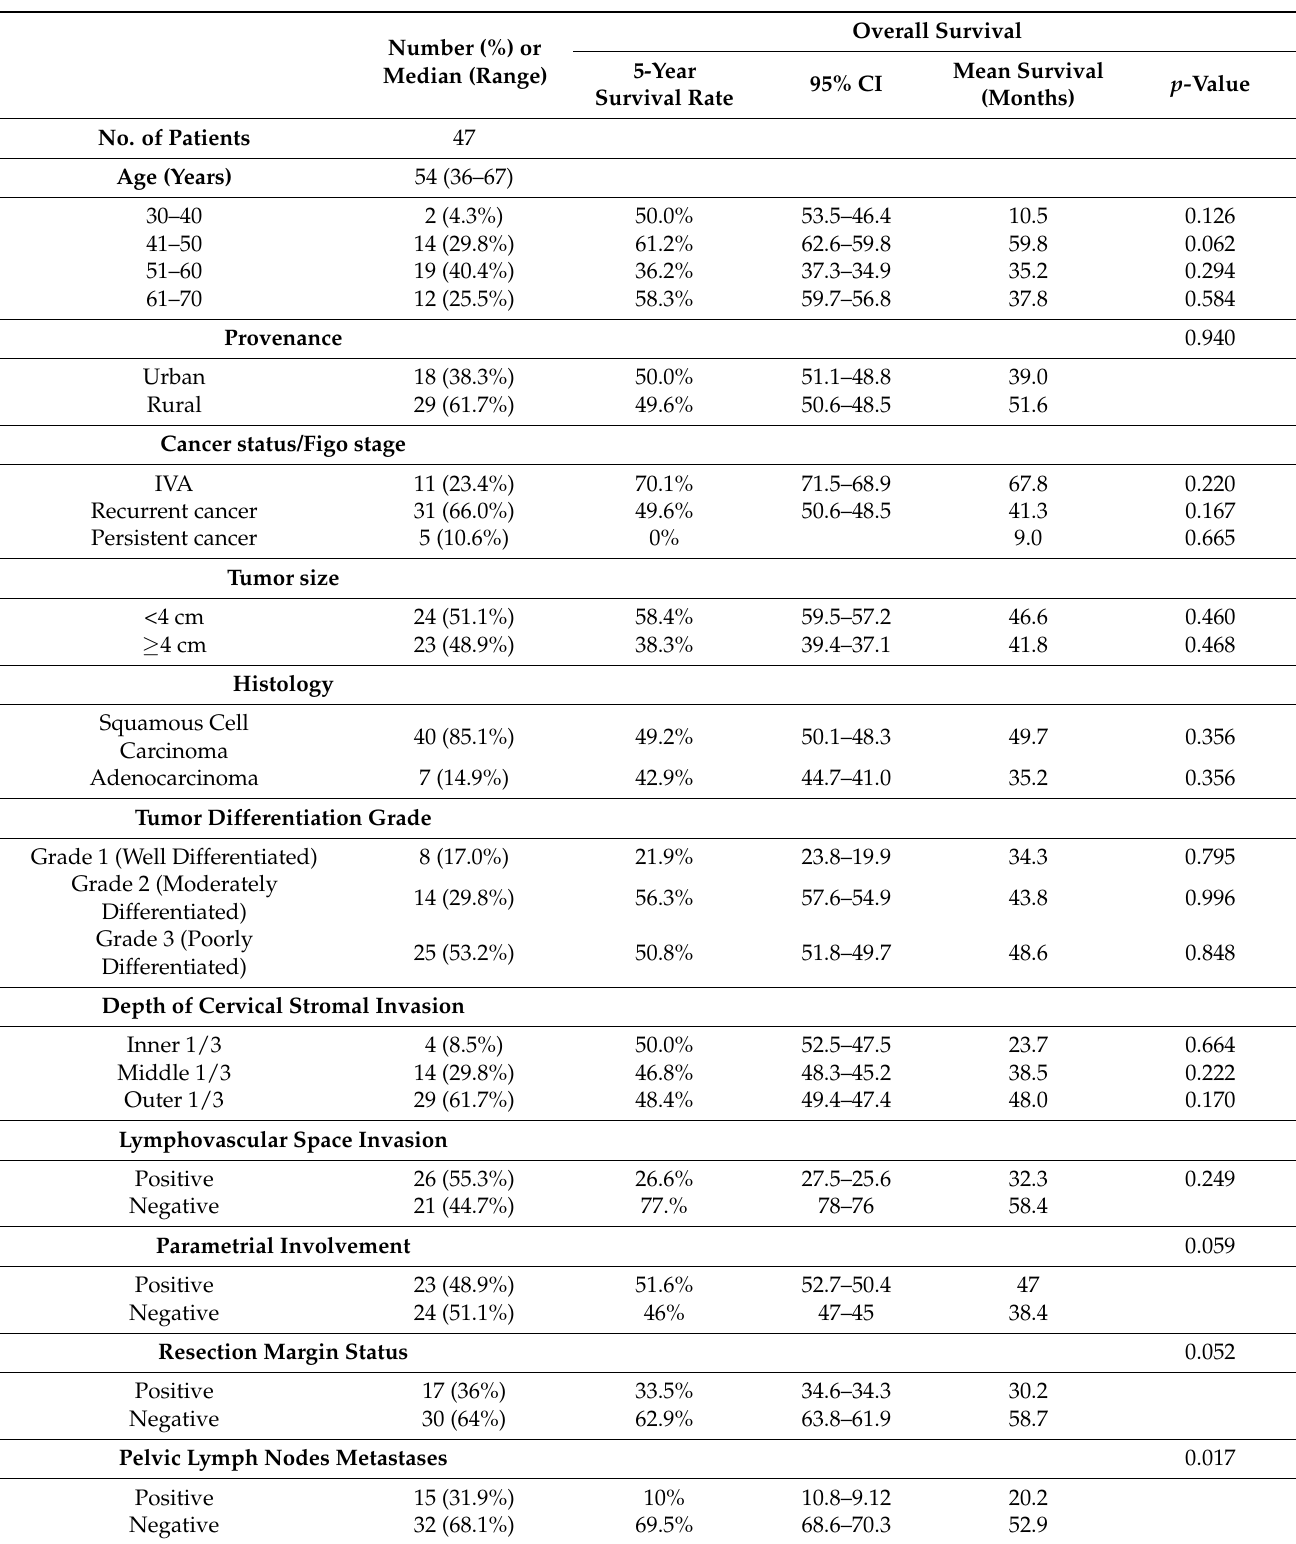
Table 1. The characteristics of the 47 patients who underwent pelvic exenterations for cervical cancer, their prognostic factors and 5-year